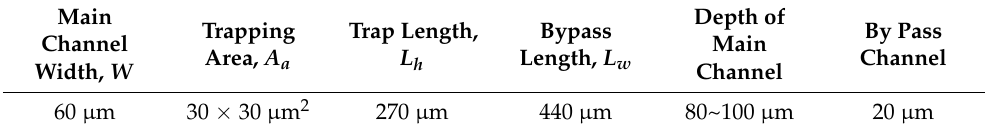
Table 1. The dimensions of the